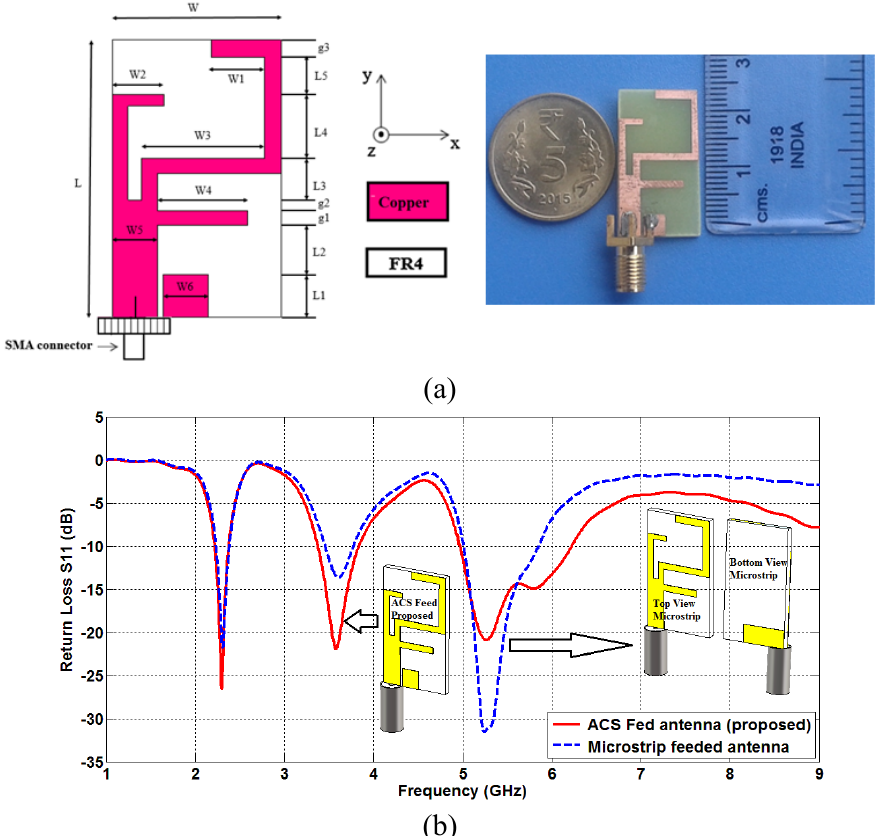
Figure 2: (a) Hardware prototype with geometry (b) |S